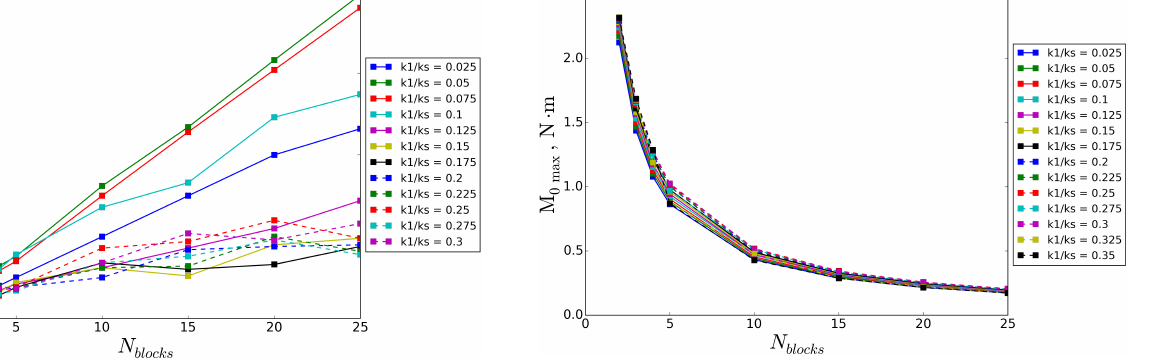
Figure 7. Cumulative number of events vs. number of blocks.